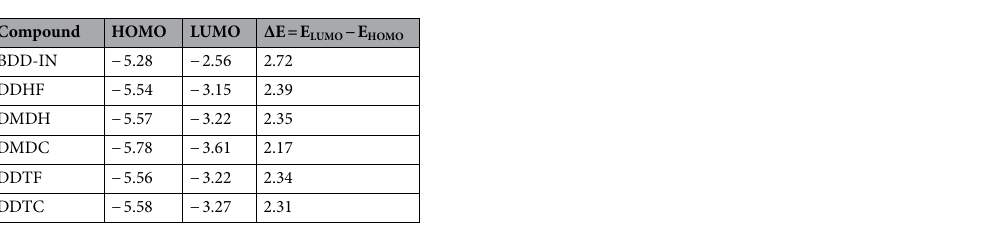
Table 1. FMO energies associated with designed and reference molecules. E energy, ΔE E LUMO − E HOMO .